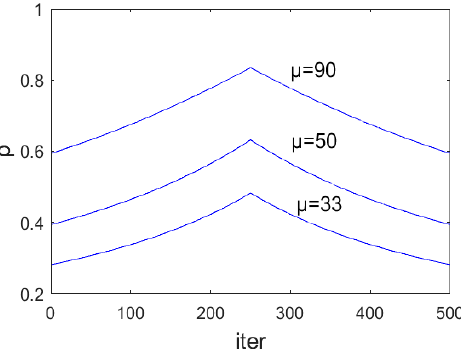
Figure 3. Adaptive change of the pheromone volatilization factor.